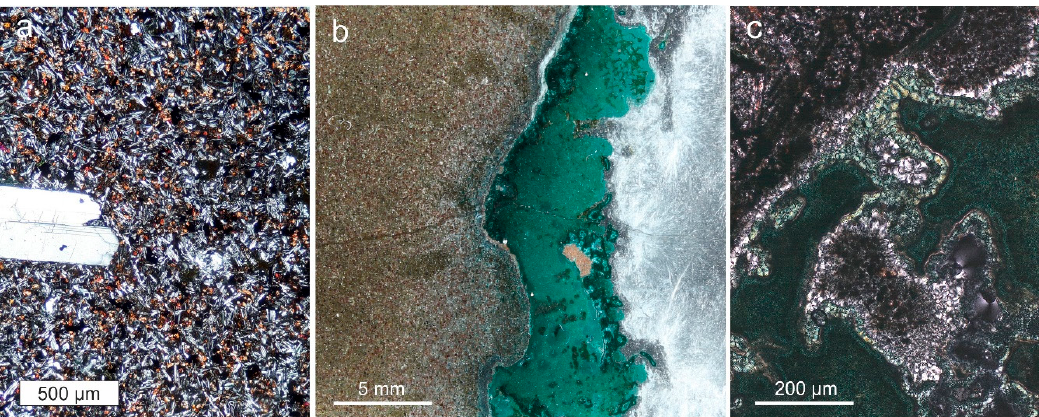
Figure 5. Micrographs showing the characteristics of the basalt in the core line of Savda and its interface with secondary mineralization. ( a ) Transmitted light micrograph (crossed polars) showing fine-grained basalt groundmass of lath-shaped plagioclase microlithes and clino-pyroxene with large plagioclase phenocryst. ( b ) Cross-section of the interface between basalt and secondary mineralization in a cavity consisting of green celadonite and needle-like zeolite crystals (mordenite) in chalcedony matrix. ( c ) Transmitted light micrograph (crossed polars) of collomorph celadonite with intercalated zeolites (stilbite/heulandite).